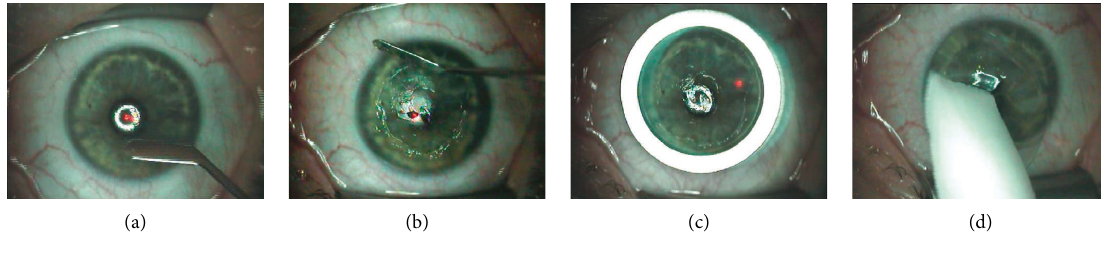
Figure 1: Steps of